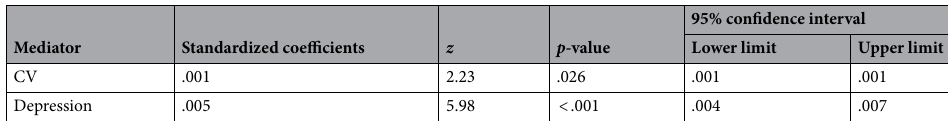
Table 5. Standardized coefficients of the indirect effect of cumulative life course adversity on TMT ratio via CV and depression. CV Coefficient of variation.